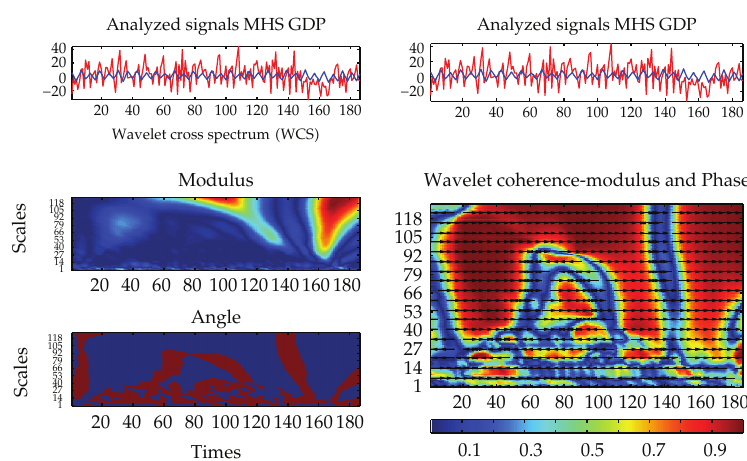
Figure 14: Wavelet cross spectrum between quarterly change of MHS and